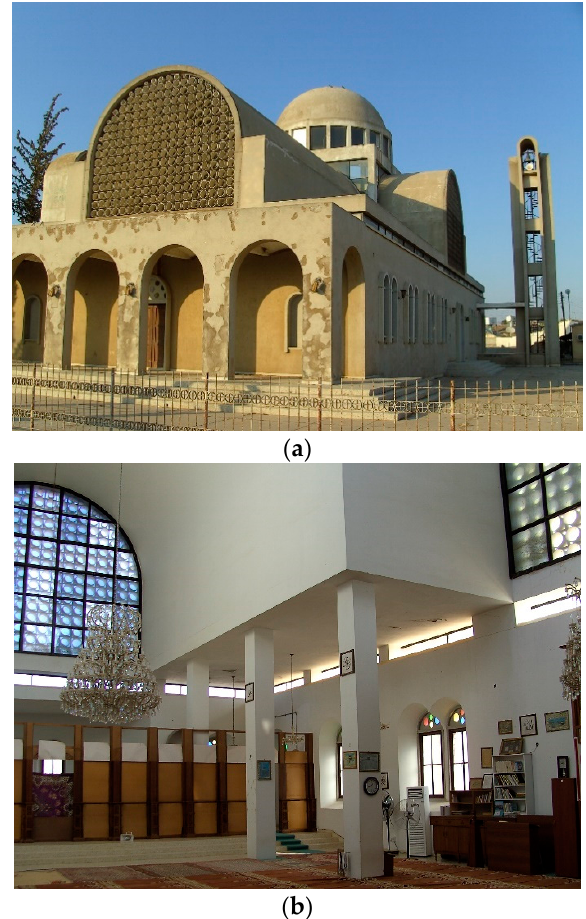
Figure 6. Zümrütköy/Katokopia, former church of the Blessed Virgin Mary, converted to a mosque after 1974: ( a ) west façade; ( b ) view from the crossing onto the disused Christian sanctuary and the southern cross-arm where the (not pictured) mihrab is installed (photos from 2014: